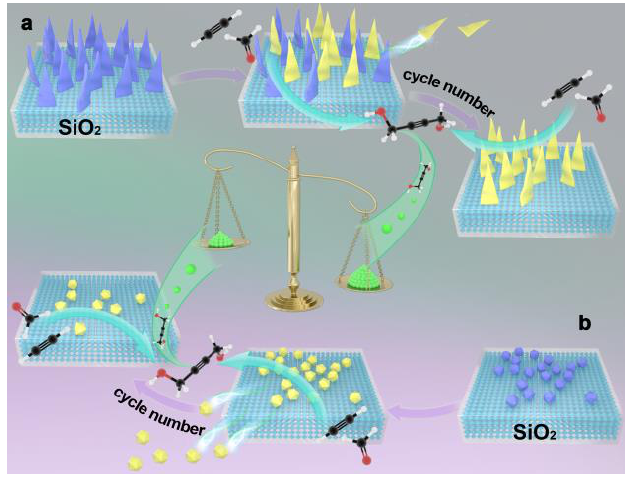
Figure 11. The conversion of ( a ) copper phyllosilicate and ( b ) CuO into active species and the loss of active species during the formaldehyde ethynylation.